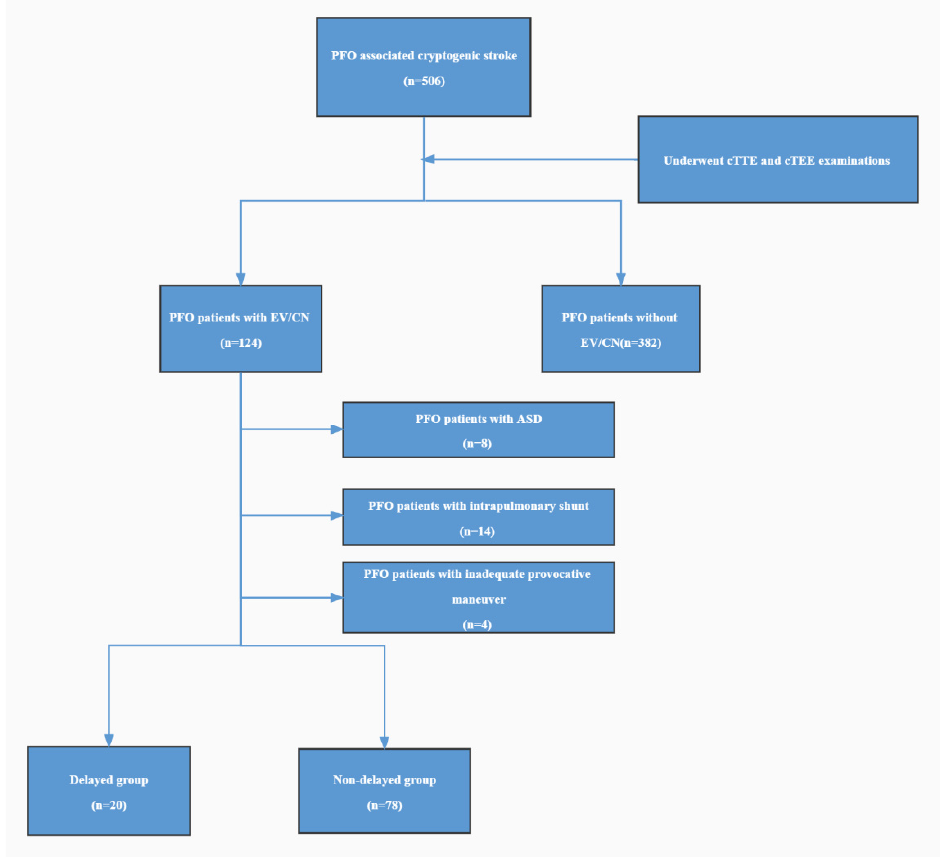
Figure 1. Flow chart. ASD = atrial septal defect; CN = Chiari Network; cTTE = contrast transthoracic echocardiography; cTEE = contrast transesophageal echocardiography; EV = Eustachian valve; PFO = patent foramen ovale.